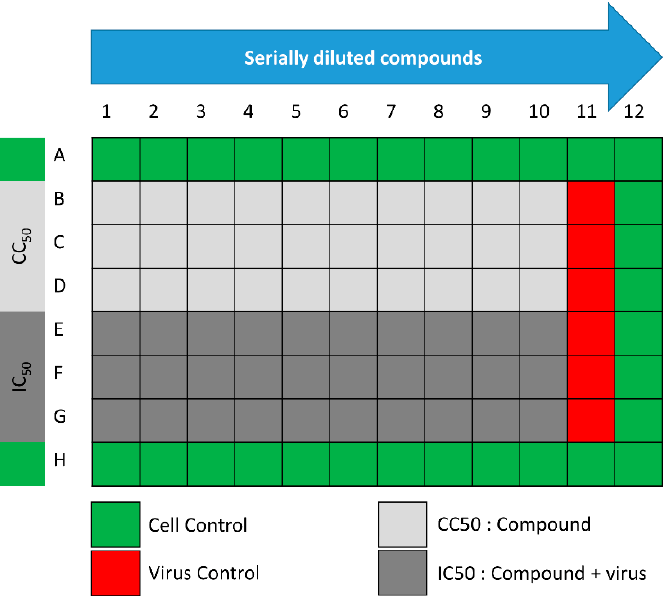
Figure 9. Schematic representation of the 96-well plates used for IC 50 and half-maximal cytotoxic concentration (CC 50 )